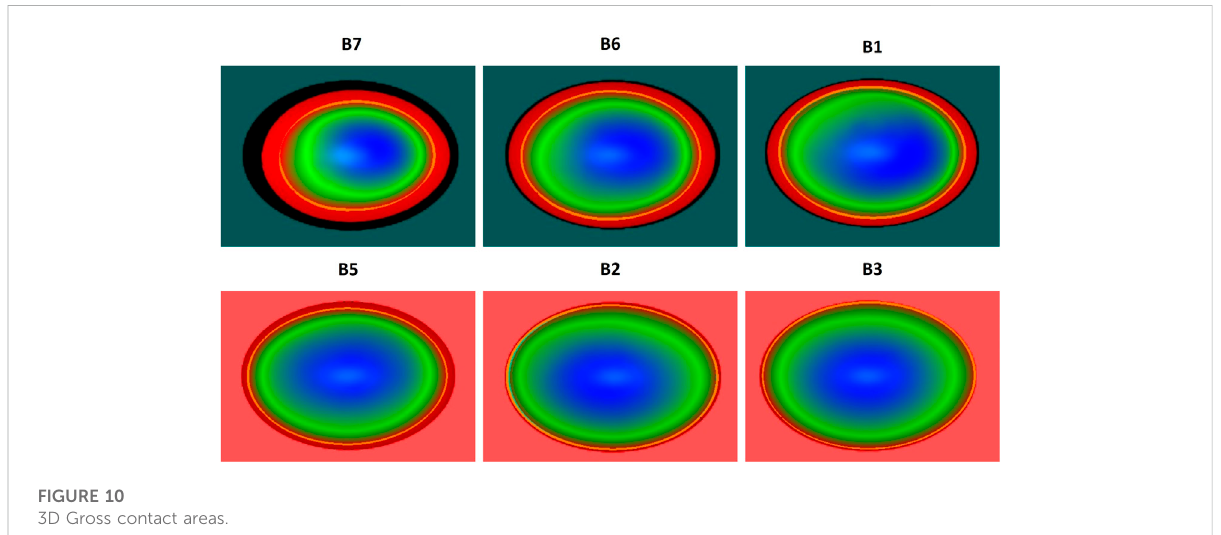
FIGURE 10 3D Gross contact areas.